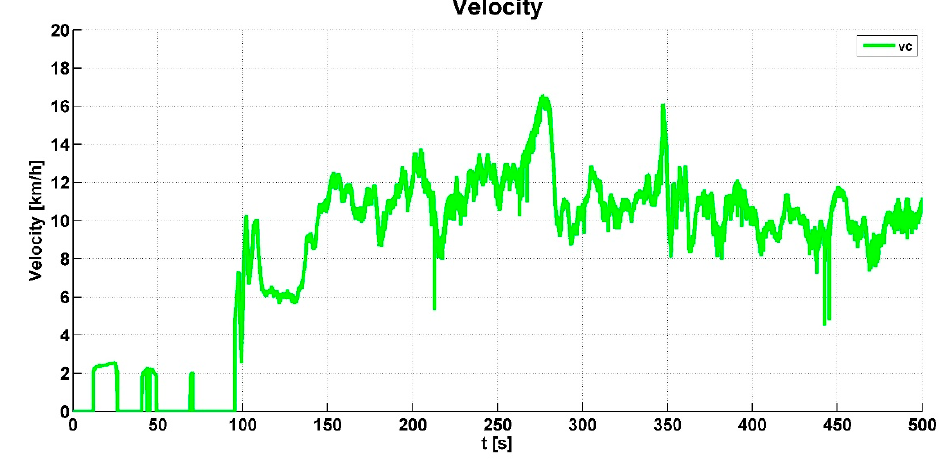
Figure 10. Vehicle speed value.